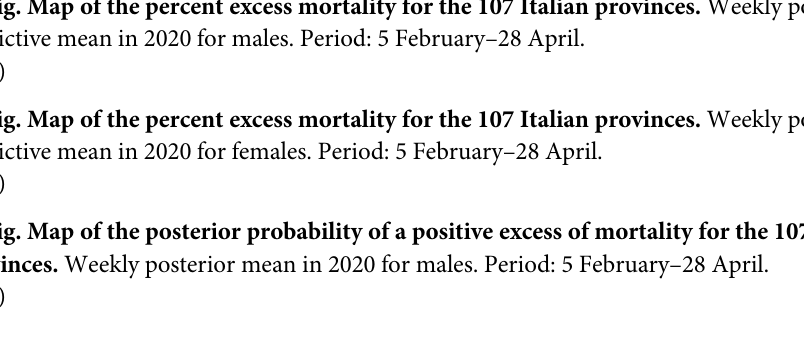
S1 Fig. Map of the percent excess mortality for the 107 Italian provinces. Weekly posterior predictive mean in 2020 for males. Period: 5 February–28 April. S2 Fig. Map of the percent excess mortality for the 107 Italian provinces. Weekly posterior predictive mean in 2020 for females. Period: 5 February–28 April. S3 Fig. Map of the posterior probability of a positive excess of mortality for the 107 Italian provinces. Weekly posterior mean in 2020 for males. Period: 5 February–28